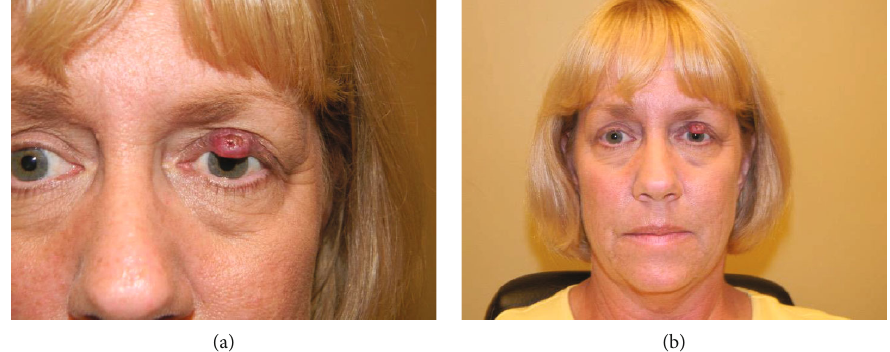
Figure 1: Merkel cell carcinoma (MCC) of the left eyelid in this patient. (a) Closeup image of tumor and (b) head-shot of the patient depicting the size of the tumor in comparison to facial